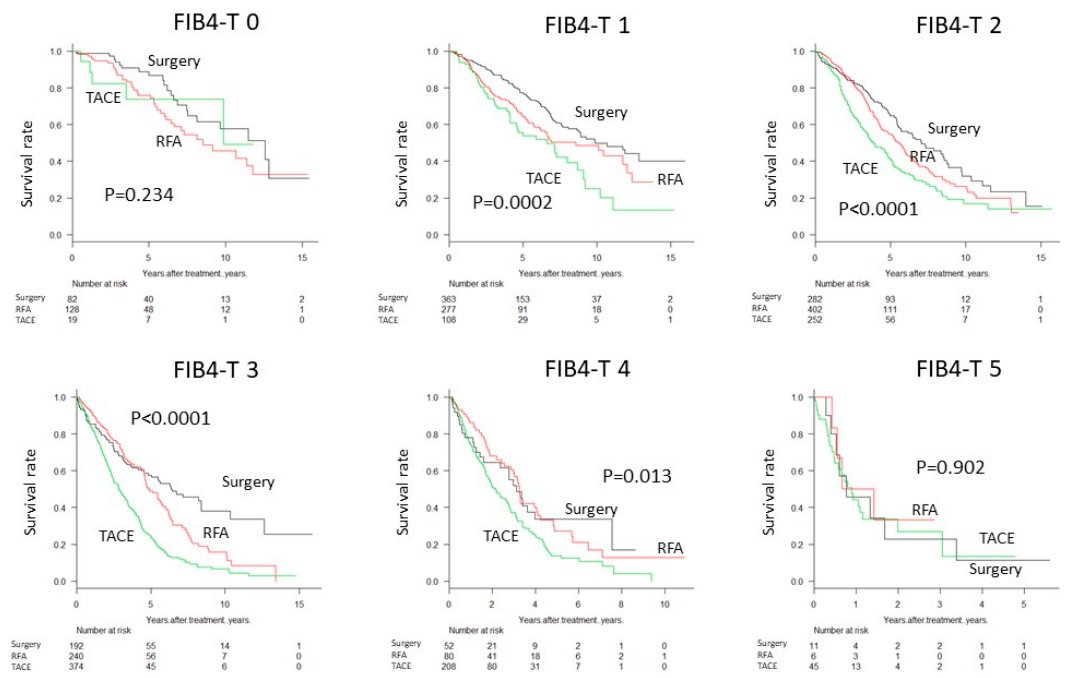
Figure 4. Survival curve stratified by treatment type (Surgery, RFA and TACE) for each grade.